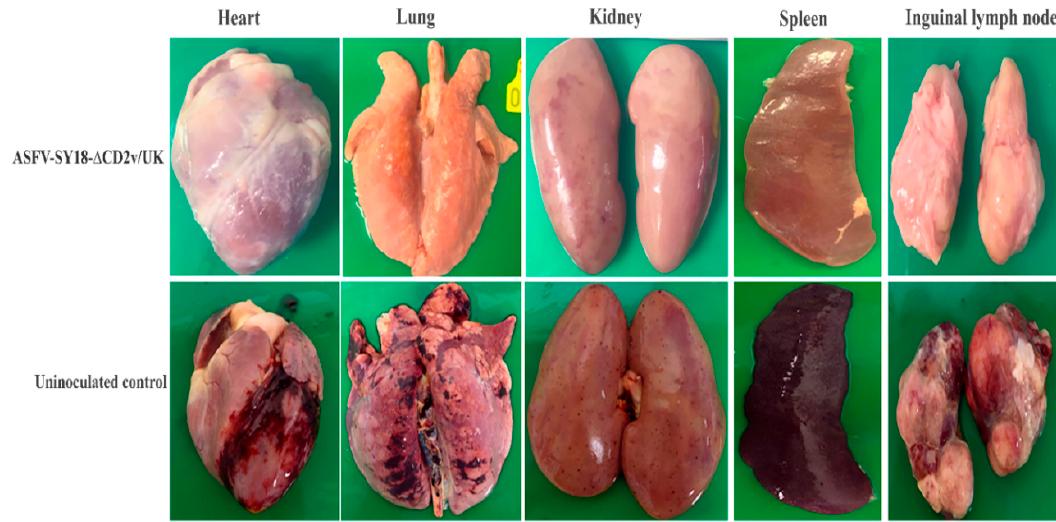
Figure 5. Macroscopic pathological lesions of the visceral organs and lymph nodes of pigs at necropsy.